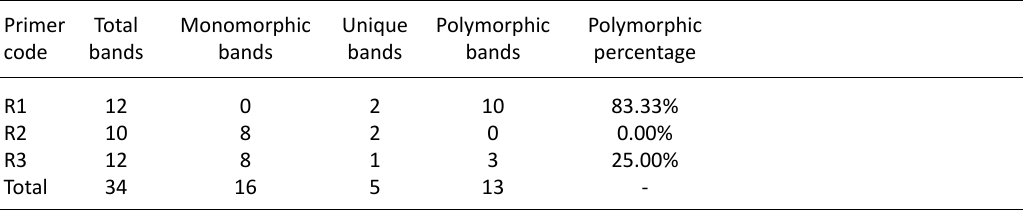
Table 7. Relationship between the tested mutant strains against wild type strain based on RAPD analysis (Proximity Matrix) Strain W.T T-40-22 T-40-29 G-60-12 code